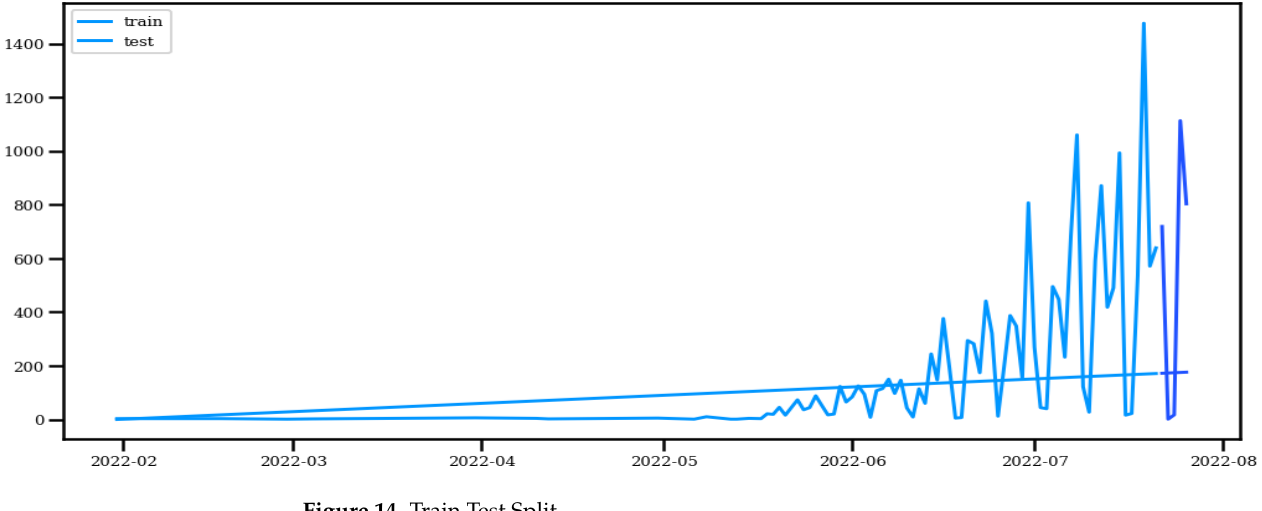
Figure 14. Train Test Split.